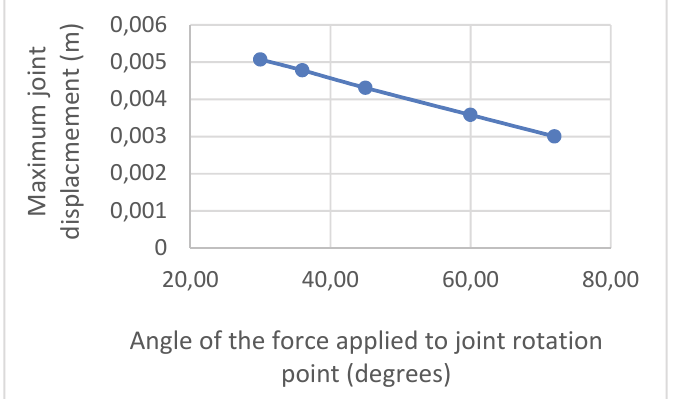
Fig. 14: Maximum value of local displacement of a joint submitted to a force of 1e4 N/m applied with different angle at a free rotation point located to the upper right part of the joint.